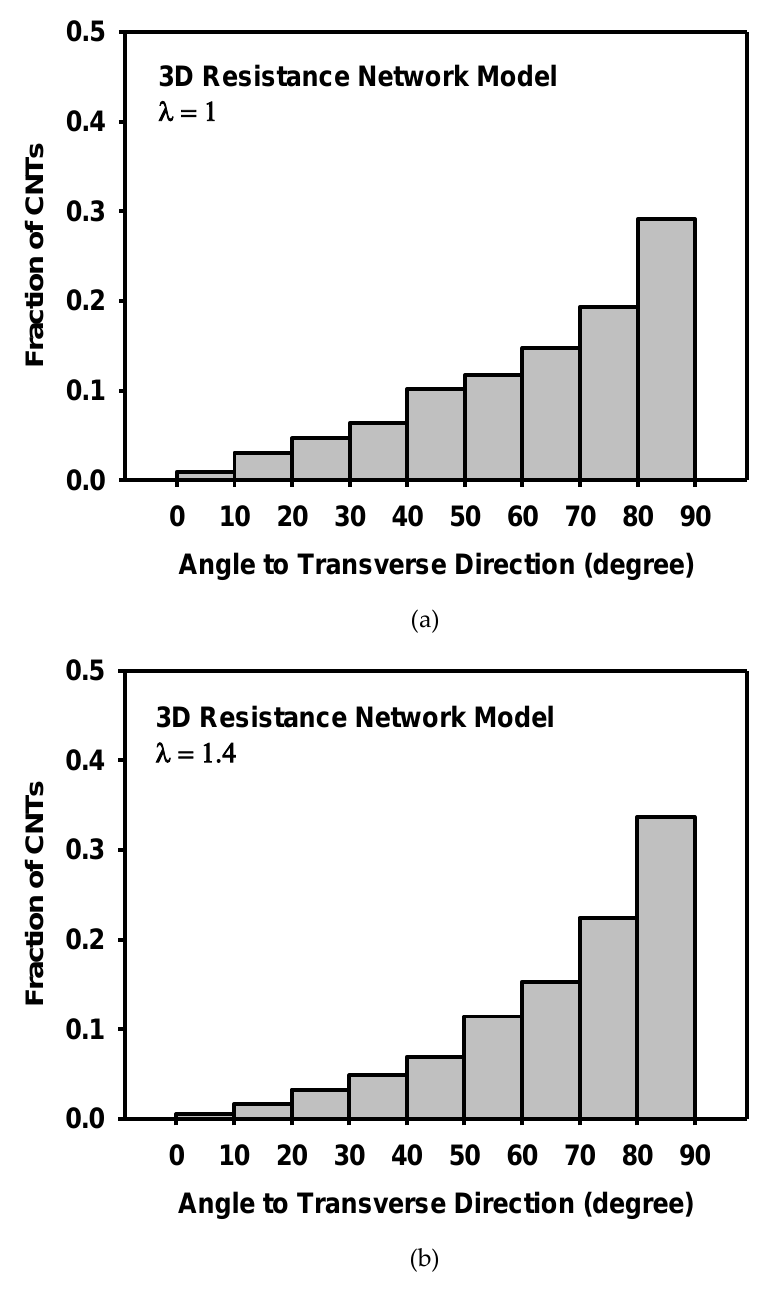
Figure 15. Distribution of the CNT angle to the transverse direction ( a ) at the initial state, and ( b ) at the stretch of 1.4 as calculated by the 3D resistance network model.